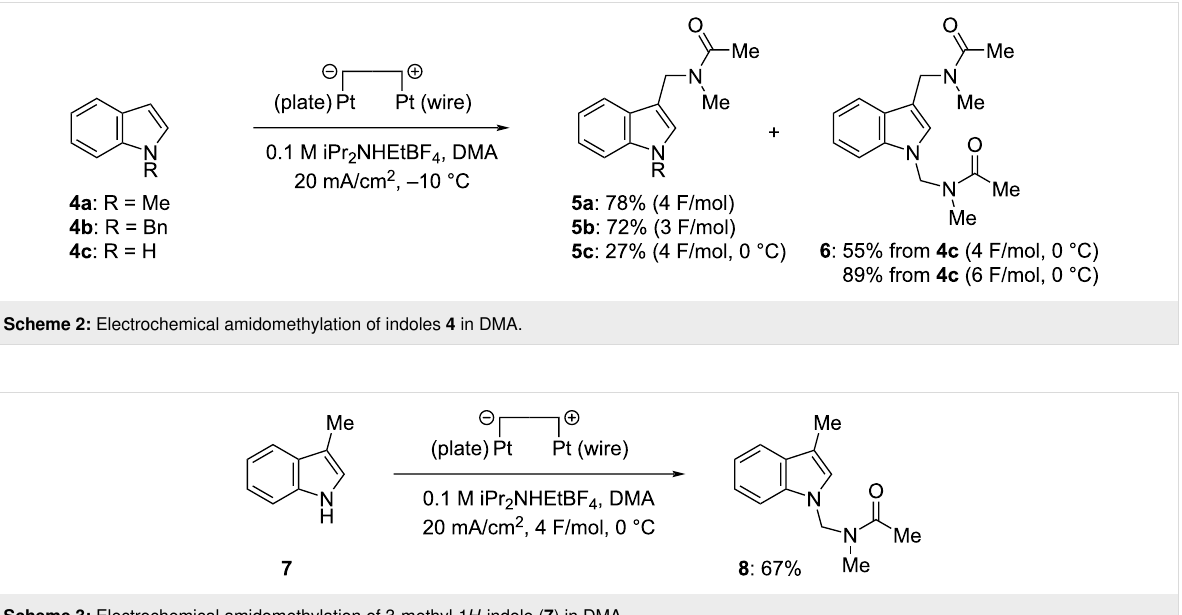
Scheme 3: Electrochemical amidomethylation of 3-methyl-1 H -indole ( 7 ) in